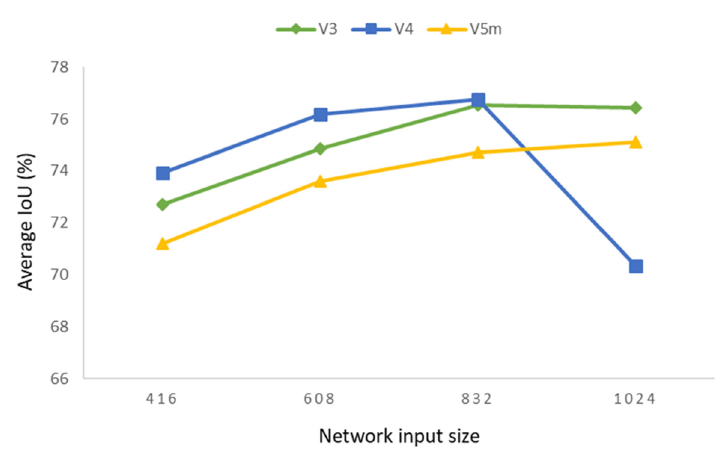
Figure 10. Comparison of the average IoU values of YOLOv3, YOLOv4, and YOLOv5m.